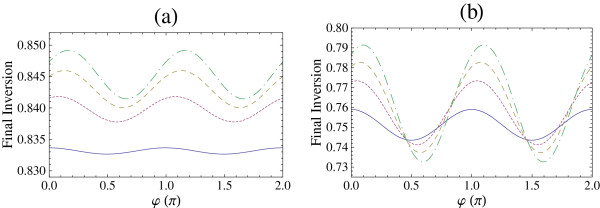
Final inversion S3(2tp) for sin-squared pulse as a function of carrier envelope phase φ. The carrier envelope phase is in multiples of Π. The excitation is on-resonance and the pulse area is θ = Π. (a) np= 2 and (b) np= 1. Solid curve: N = 109cm−2, dotted curve: N = 3 × 1011cm−2, dashed curve: N = 5 × 1011cm−2, and dot-dashed curve: N = 7 × 1011cm−2.